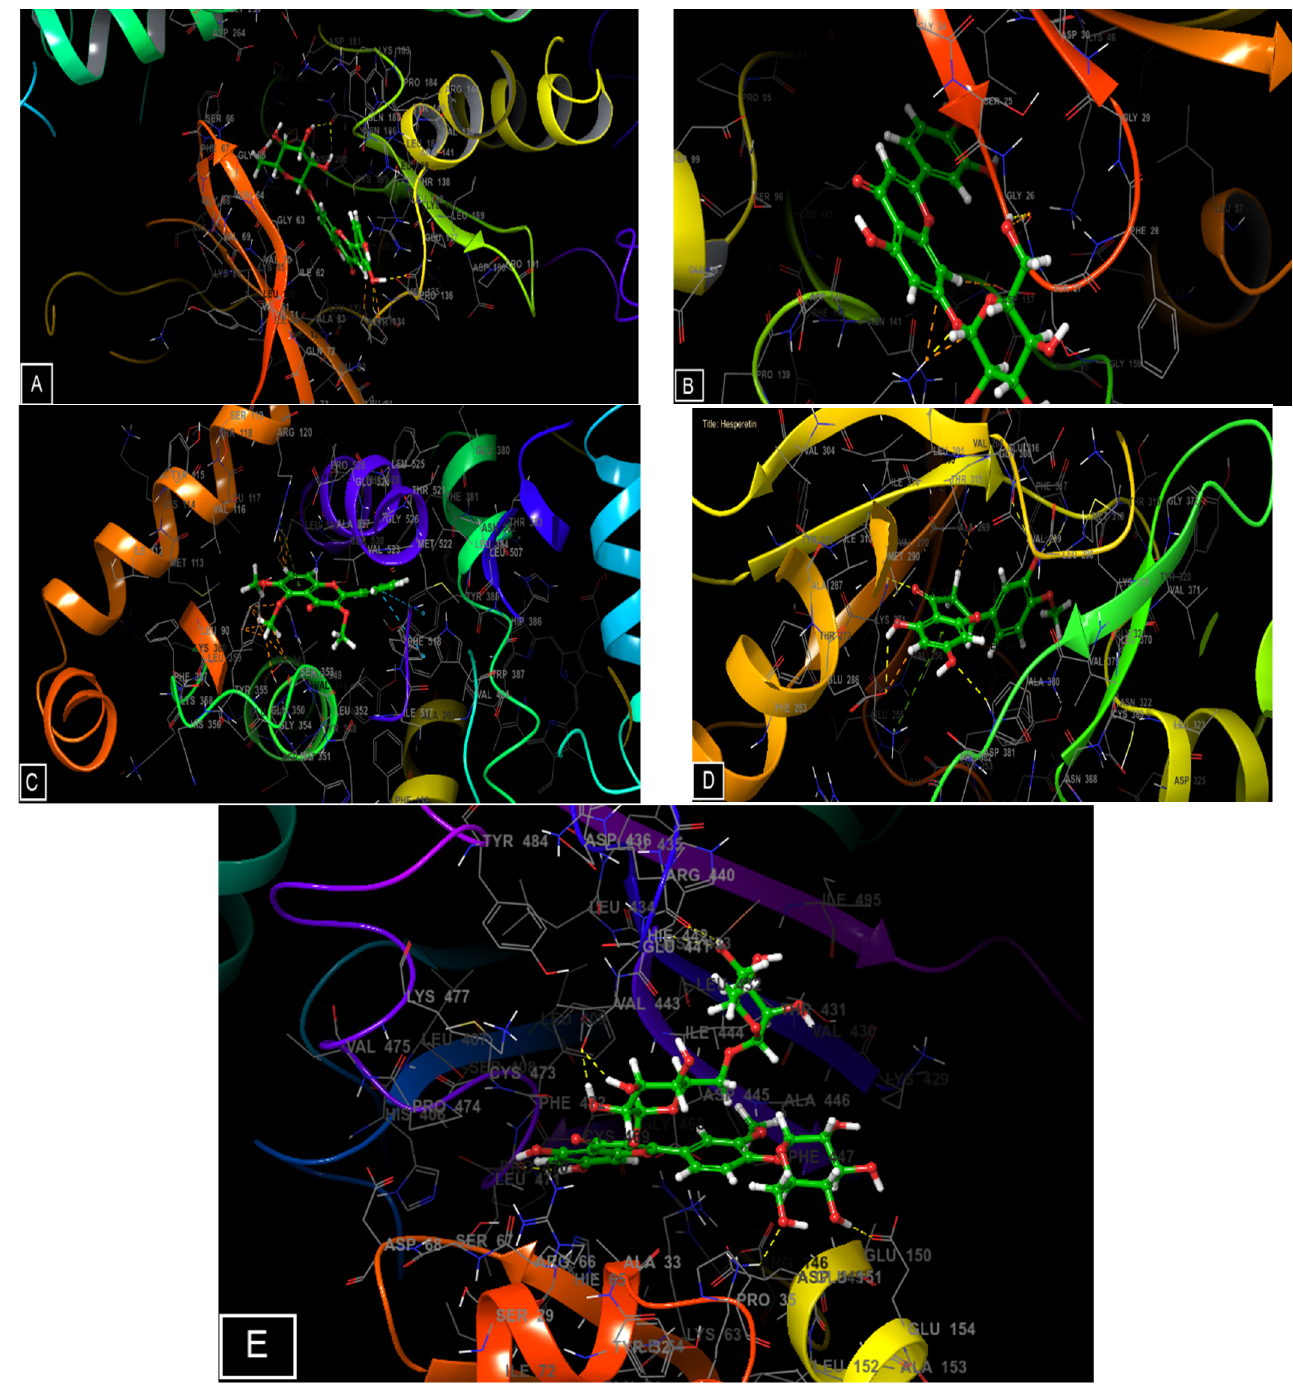
Figure 7. 3D diagrams of candidate ligand interactions with the active sites. ( A and B ) luteolin 7- O - glucoside interactions with the active site of GSK3- β and CK-1, respectively. ( C ) Trimethoxyflavone interactions with the active site of cyclooxygenase-2. ( D ) Hesperetin interactions with the active site of Tyrosine kinase. ( E ) isorhamnetin-3- O -rutinoside interactions with the active site of TRADD.